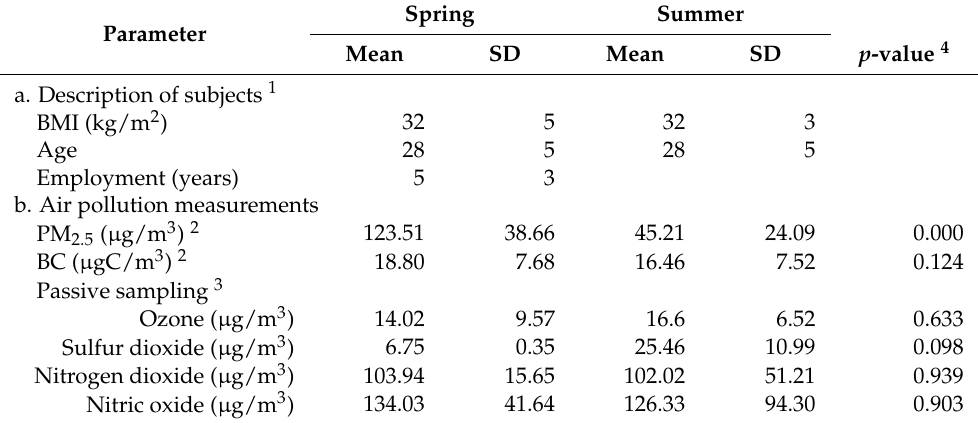
Table 1. Description of study subjects and air pollution during spring ( n = 33) and summer ( n =